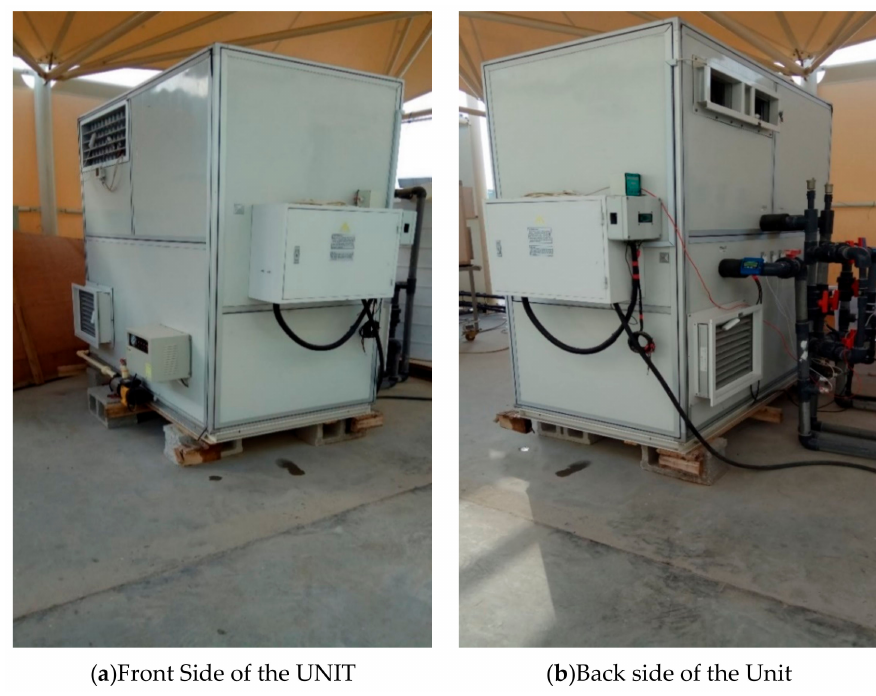
Figure 1. Experimental setup at GORD TechnoHub Doha, Qatar.